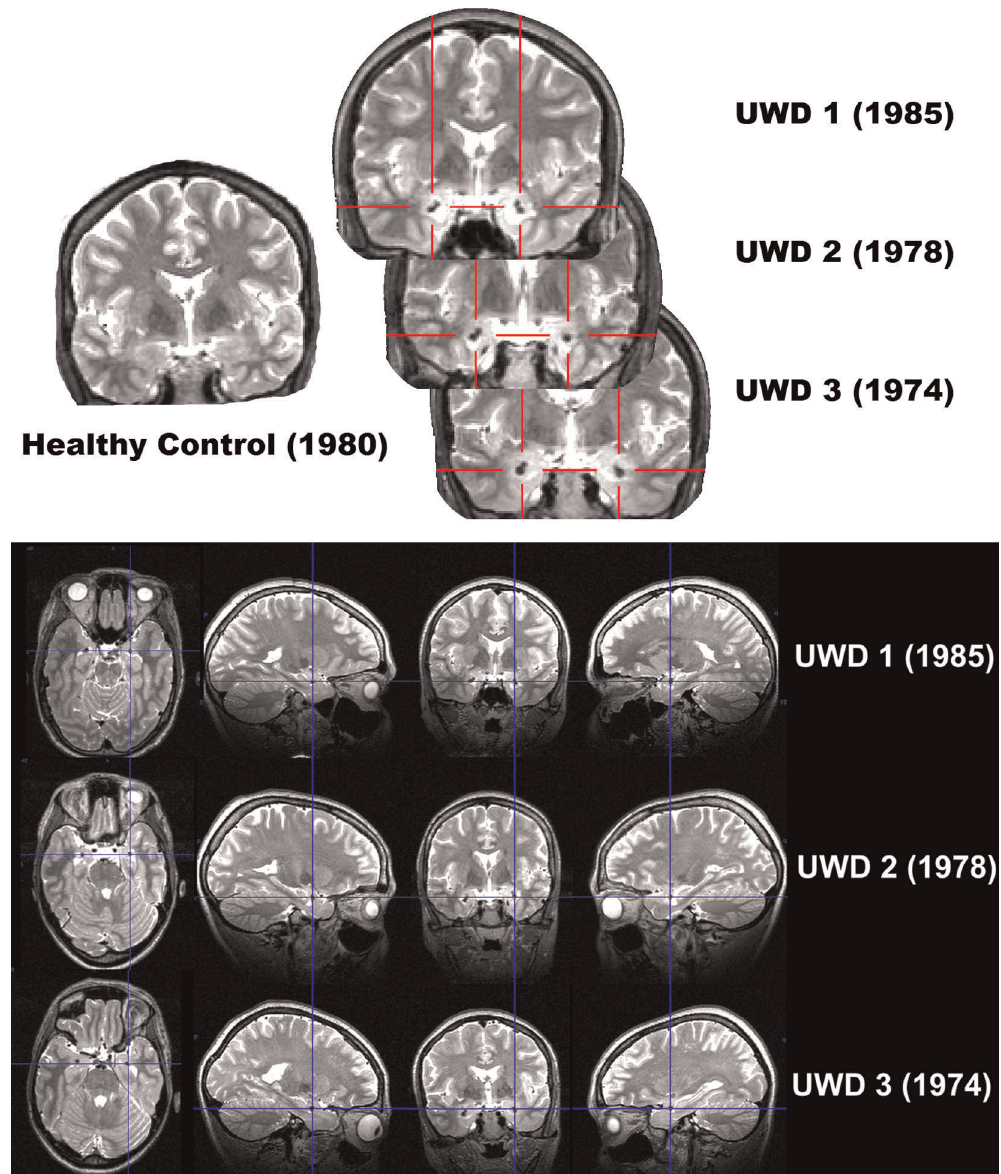
Figure 2. Structural MRI scans showing bilateral amygdala calcification in UWD. Figure 2a: Coronal view T2-weighted MR-images of the three UWD subjects and one control subject with year of birth. Crosshairs indicate calcified brain damage. Figure 2b: T2-weighted MR-images in all three planes of the three UWD subjects. Crosshairs indicate the location of calcified brain damage bilaterally.